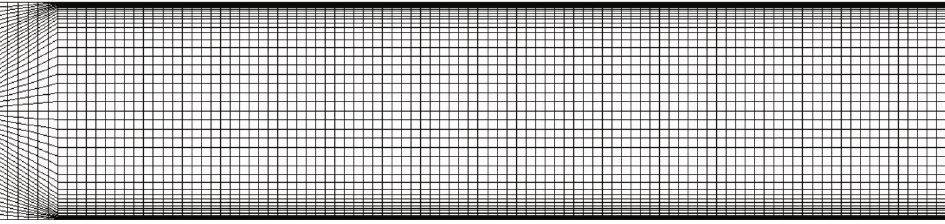
Figure 3: The grid of the smooth fracture.